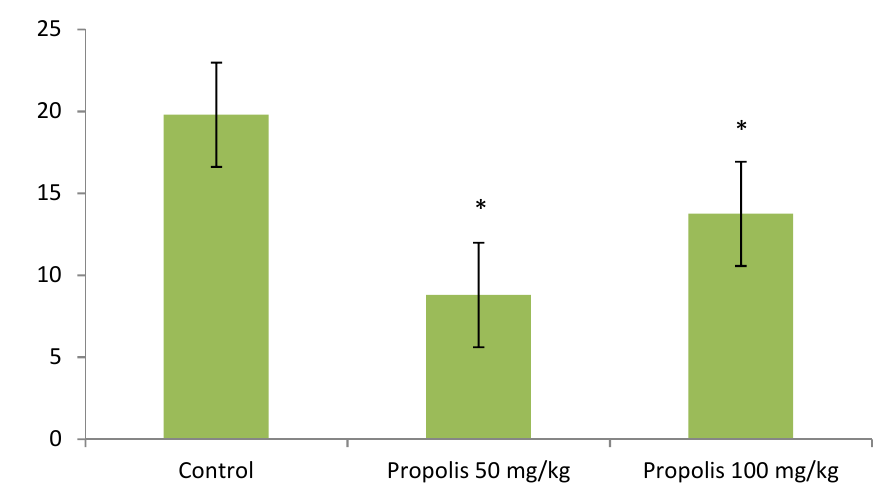
Figure 3. Effect of green Brazilian propolis alcohol extract (P50 and P100) against acetic acid-induced abdominal contraction in rats. The values expressed are mean ± SEM ( n = 6).* p < 0.05: significantly different for treated (P50 and P100) compared to the control groups as determined by ANOVA analysis followed by multiple comparison post hoc test.